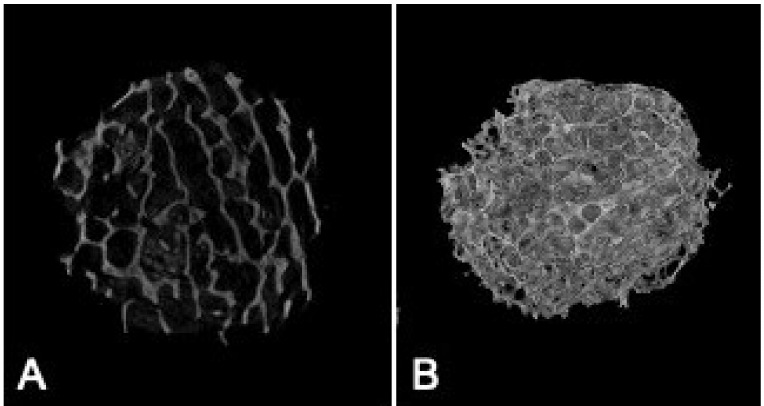
Figure 7. Representative µ -CT images of the CBHA scaffold. ( A ) The 2D cross section of the BHA scaffold; ( B ) The 3D rendering of the CBHA